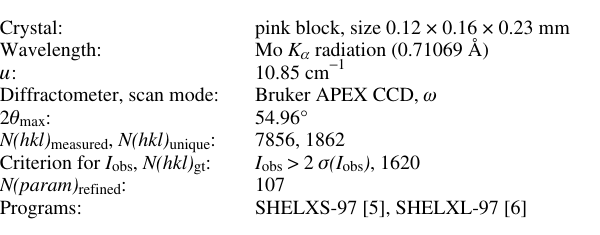
Table 1. Data collection and handling.